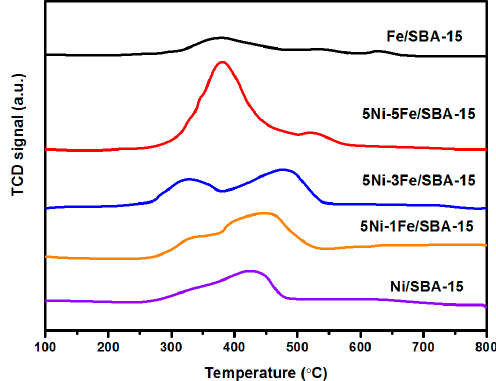
Figure 3. H 2 -TPR (hydrogen temperature-programmed reduction) profiles of Ni / SBA-15, 5Ni-1Fe / SBA-15, 5Ni-3Fe / SBA-15, and 5Ni-5Fe / SBA-15 catalysts.